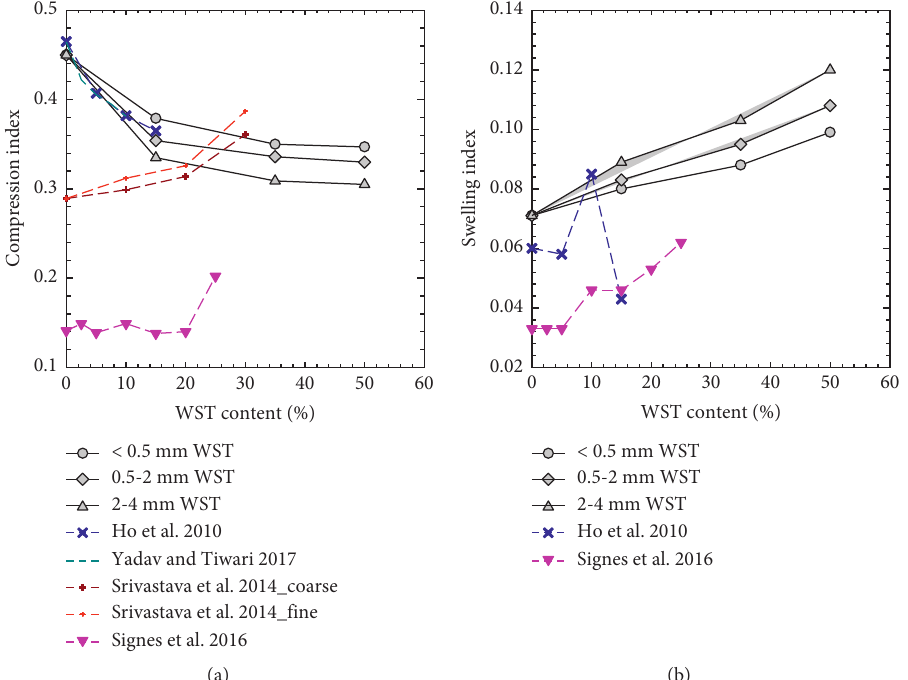
Figure 4: (a) Compression index and (b) swelling index of WST-reinforced clays with WST